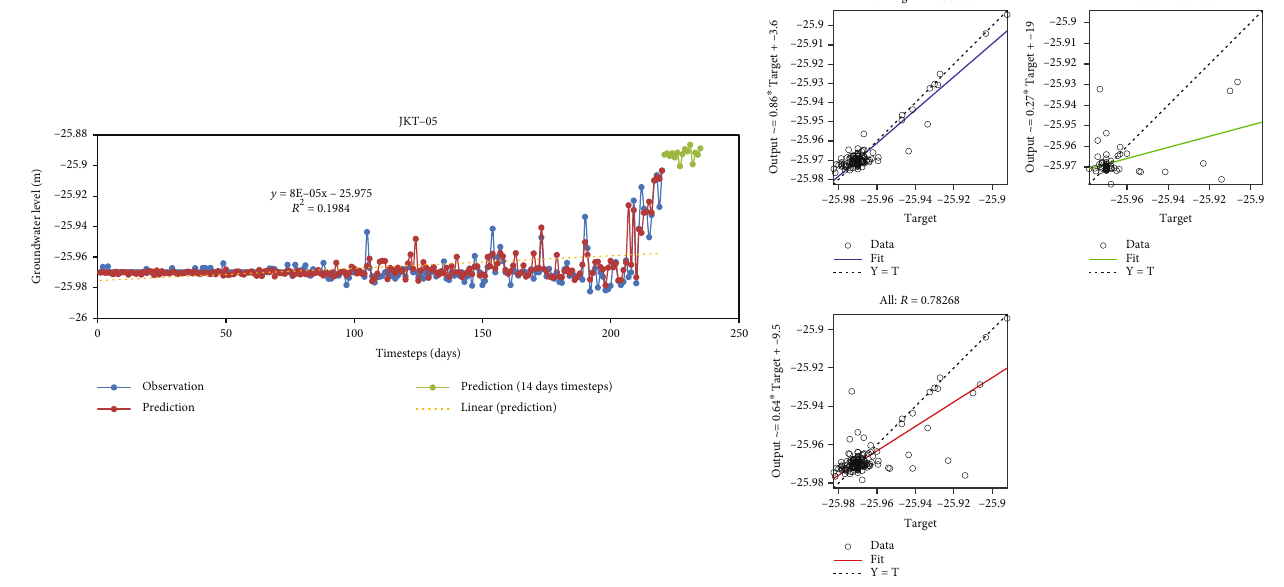
Figure 9: NARX prediction and model performance for